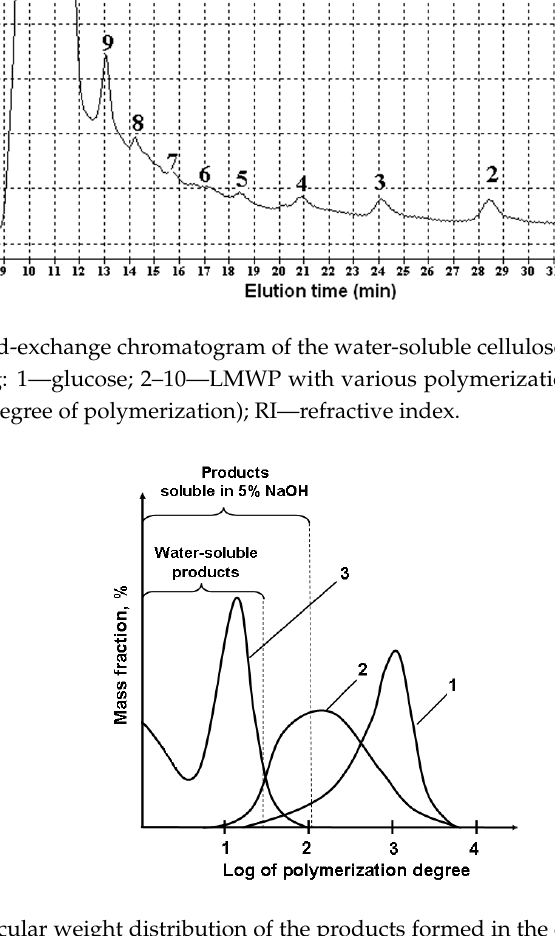
Figure 4. The molecular weight distribution of the products formed in the cellulose EBP-processing: 1—original cellulose; 2—cellulose treated in the EBP for 2 min; 3—cellulose treated in the EBP for 10 min.